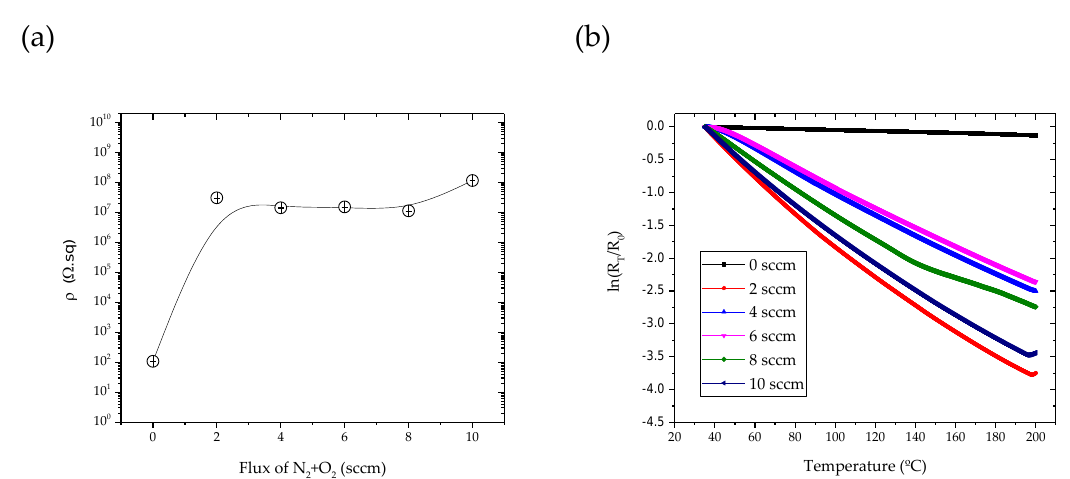
Figure 7. ( a ) Room temperature electrical resistivity as a function of the N 2 + O 2 flux and ( b ) thermoresistive response of samples of TiCu(O,N) thin films sputtered on glass substrates.